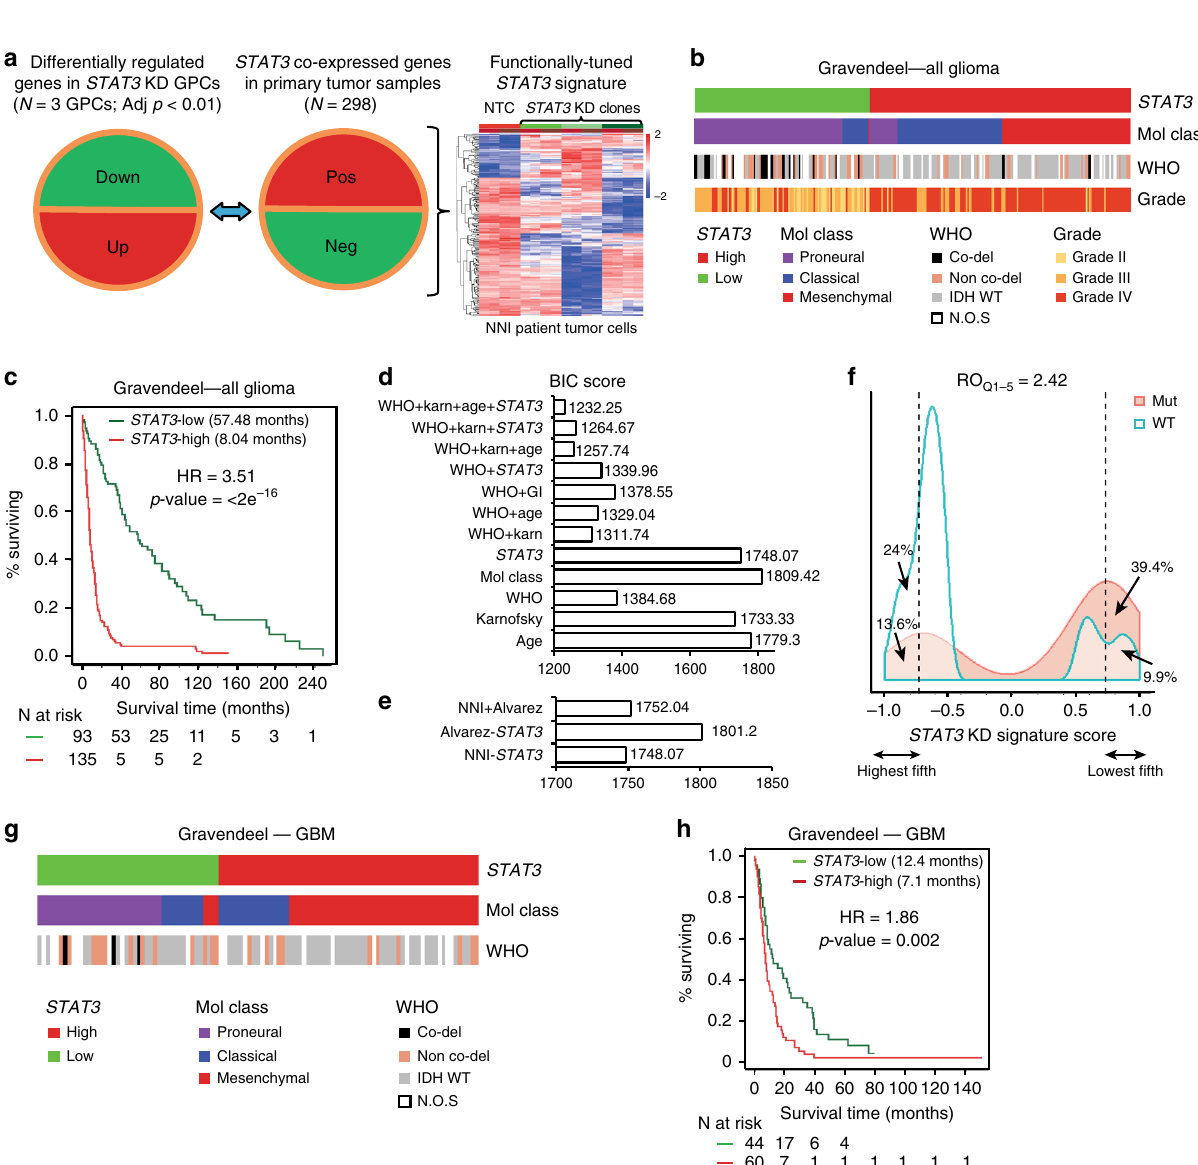
molecular subtypes, typifying highly aggressive and recurrent gliomas (Supplementary Table 1a). These tumors also demon- strated a signi fi cant enrichment of 1p/19q non-co-deletion and IDH-WT status. STAT3 -low tumors, in contrast, comprise mostly of low-grade gliomas (LGGs), and the proneural molecular sub- type with enrichment of 1p/19q co-deletion and IDH-Mut (mutant) status, representing tumors of better prognosis and